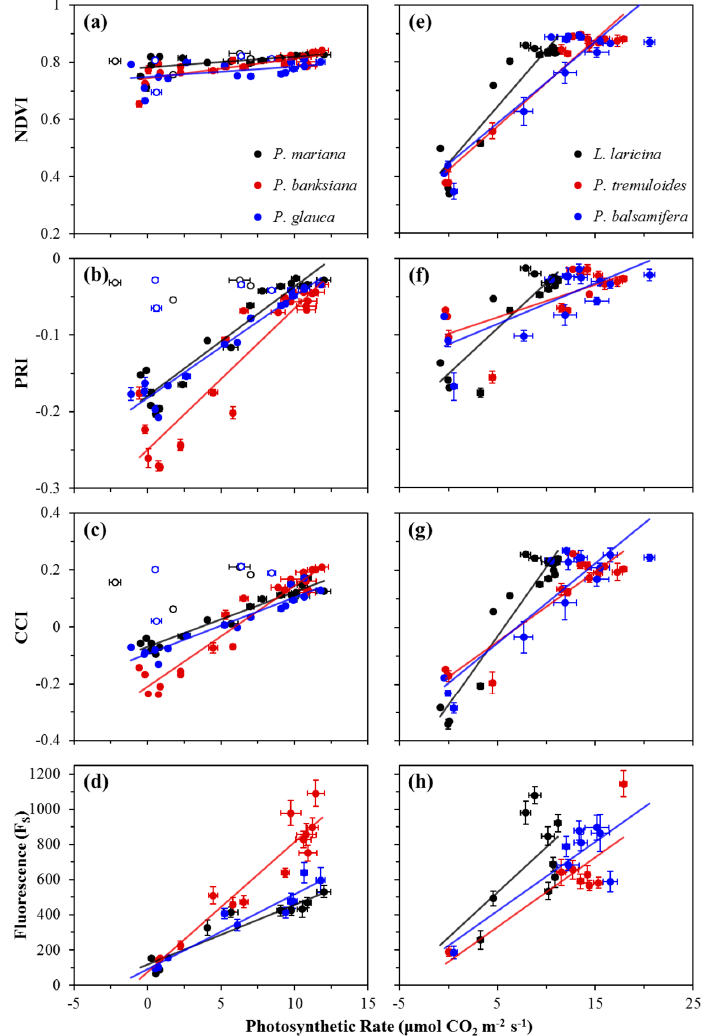
Figure 4 . Correlations between photosynthetic rate ( μ mol CO 2 m − 2 s − 1 ) and the NDVI, PRI, CCI, or Fs for evergreen ( a − d ) and deciduous ( e − h ) species. Data points were obtained near solar noon from January 2016 to December 2016. Error bars denote ±SE of the mean. Open points ( a − c ) denote dates when new branches were sampled for P. mariana and P. glauca ; these points were excluded from analyses.